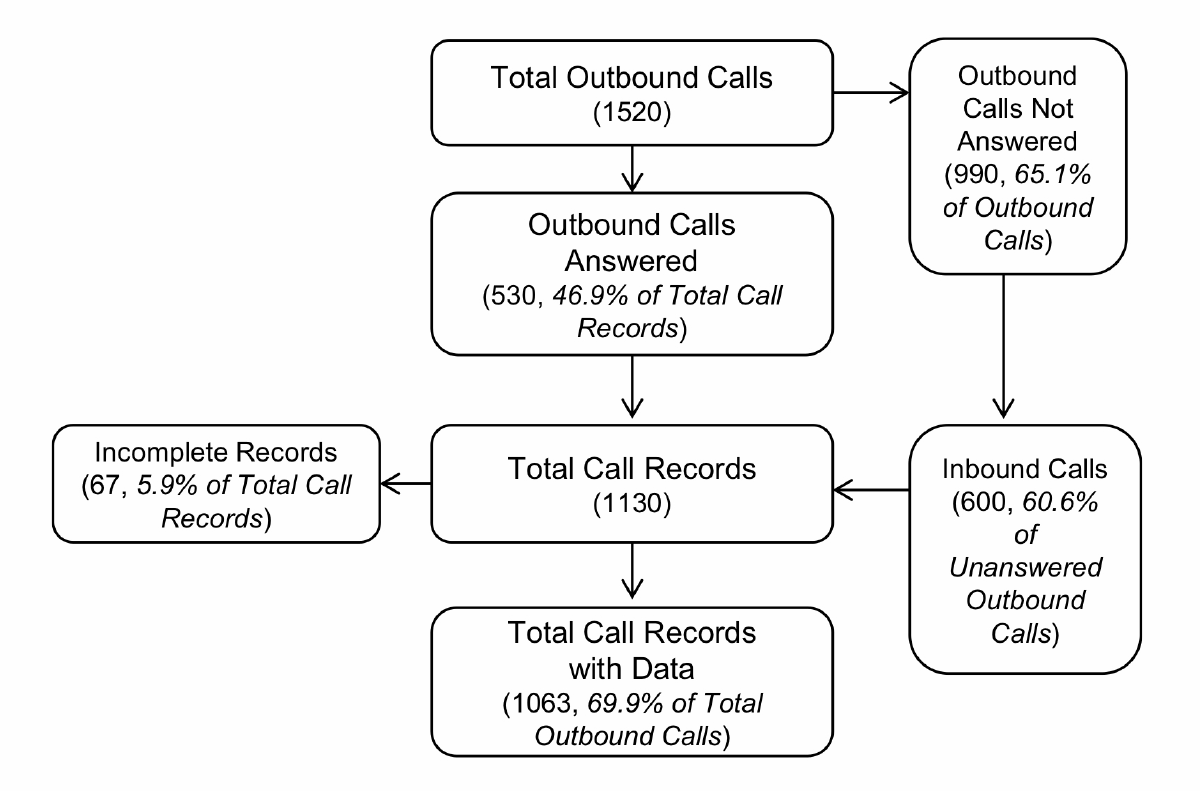
Figure 2. Flow diagram of daily EMA